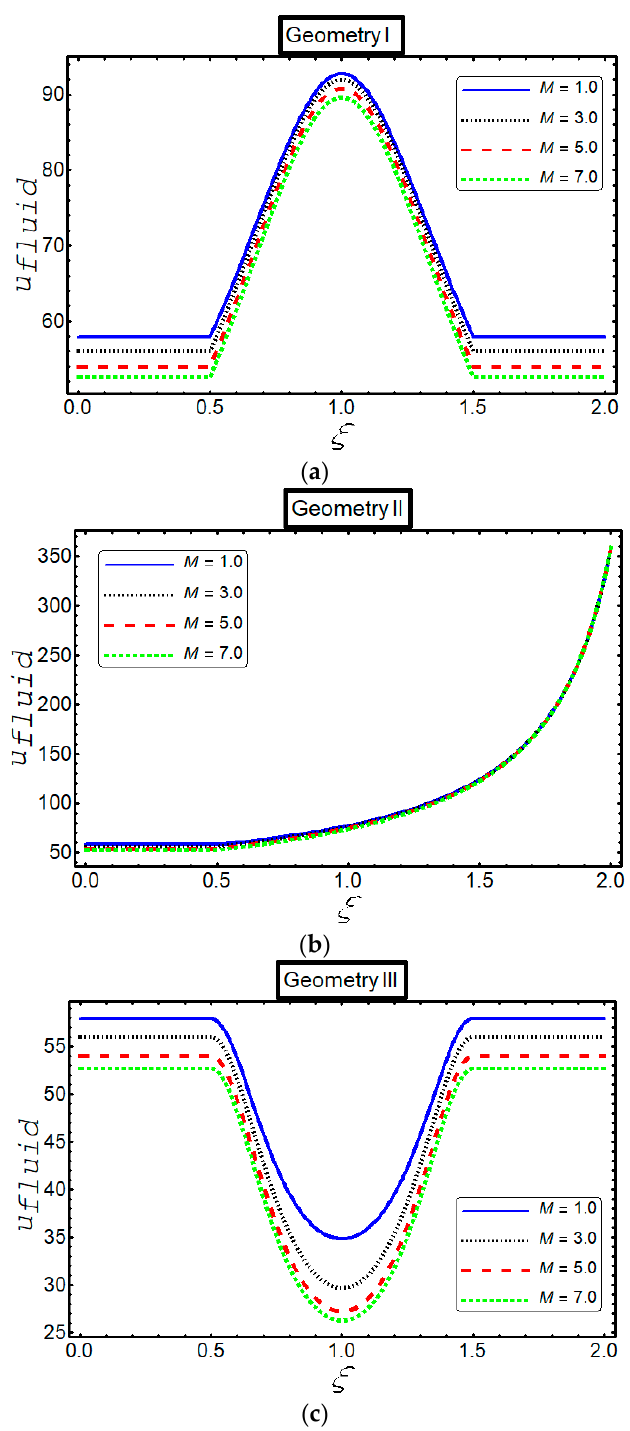
Figure 4. Velocity variation for Hartmann number.